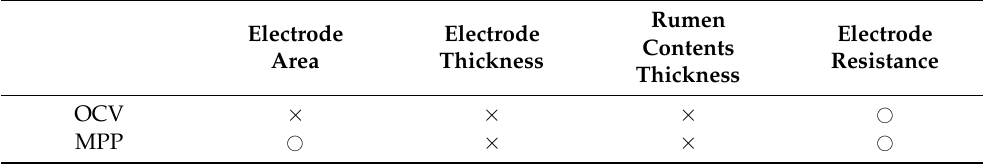
Table 2. Summary of the relationship between experimented parameters and the OCV and MPP. means there is a correlation and × means there is no